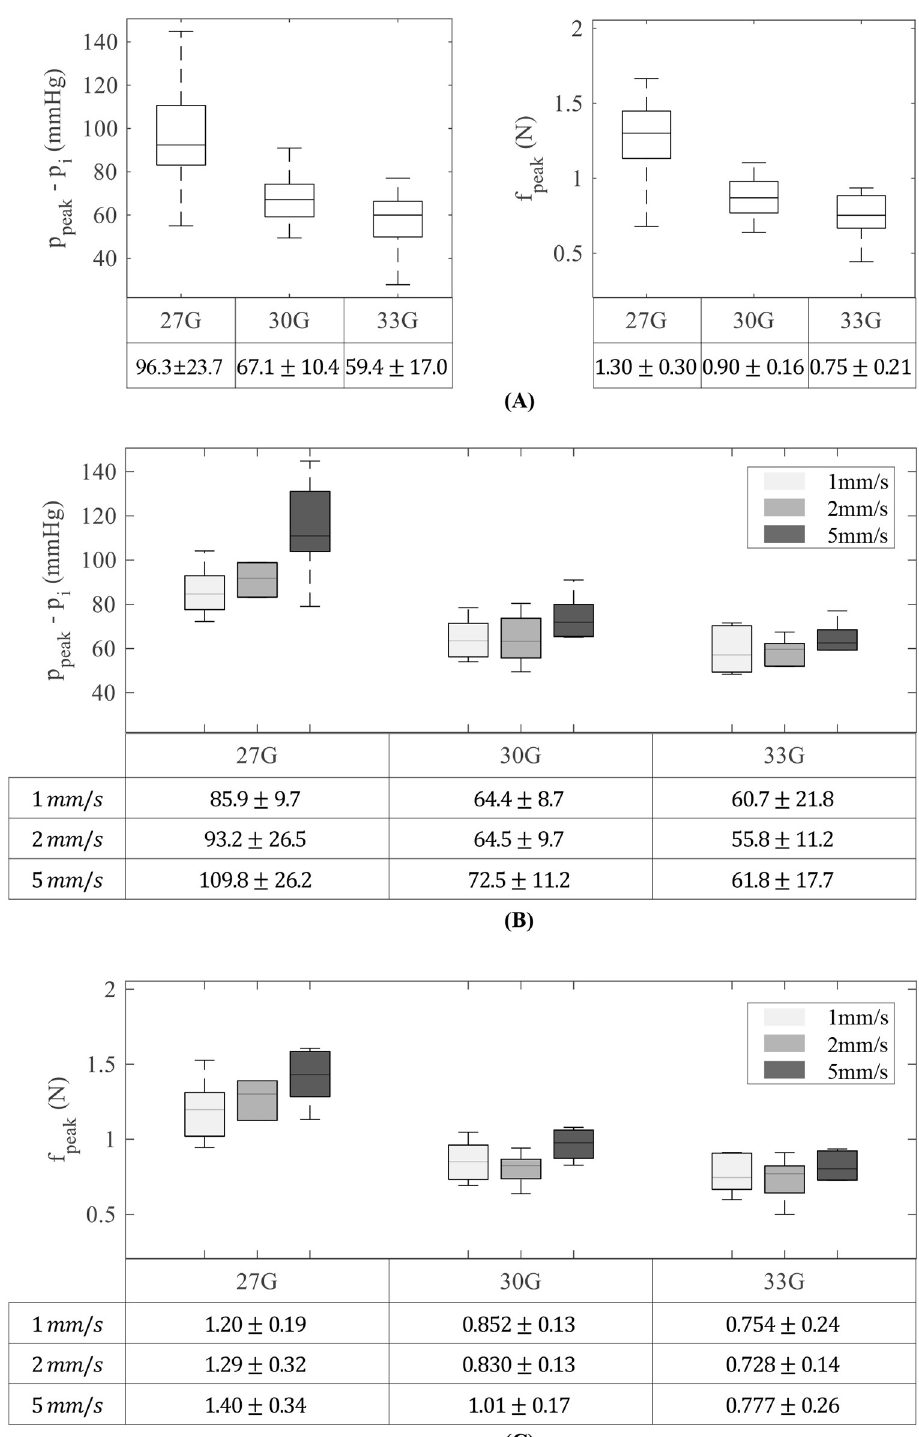
Fig 3. Pressure elevation and peak force in the insertion stage. According to A: needle gauge and B, C: insertion speed. Each subgroup contains 30 samples in A, and 10 samples in B and C.